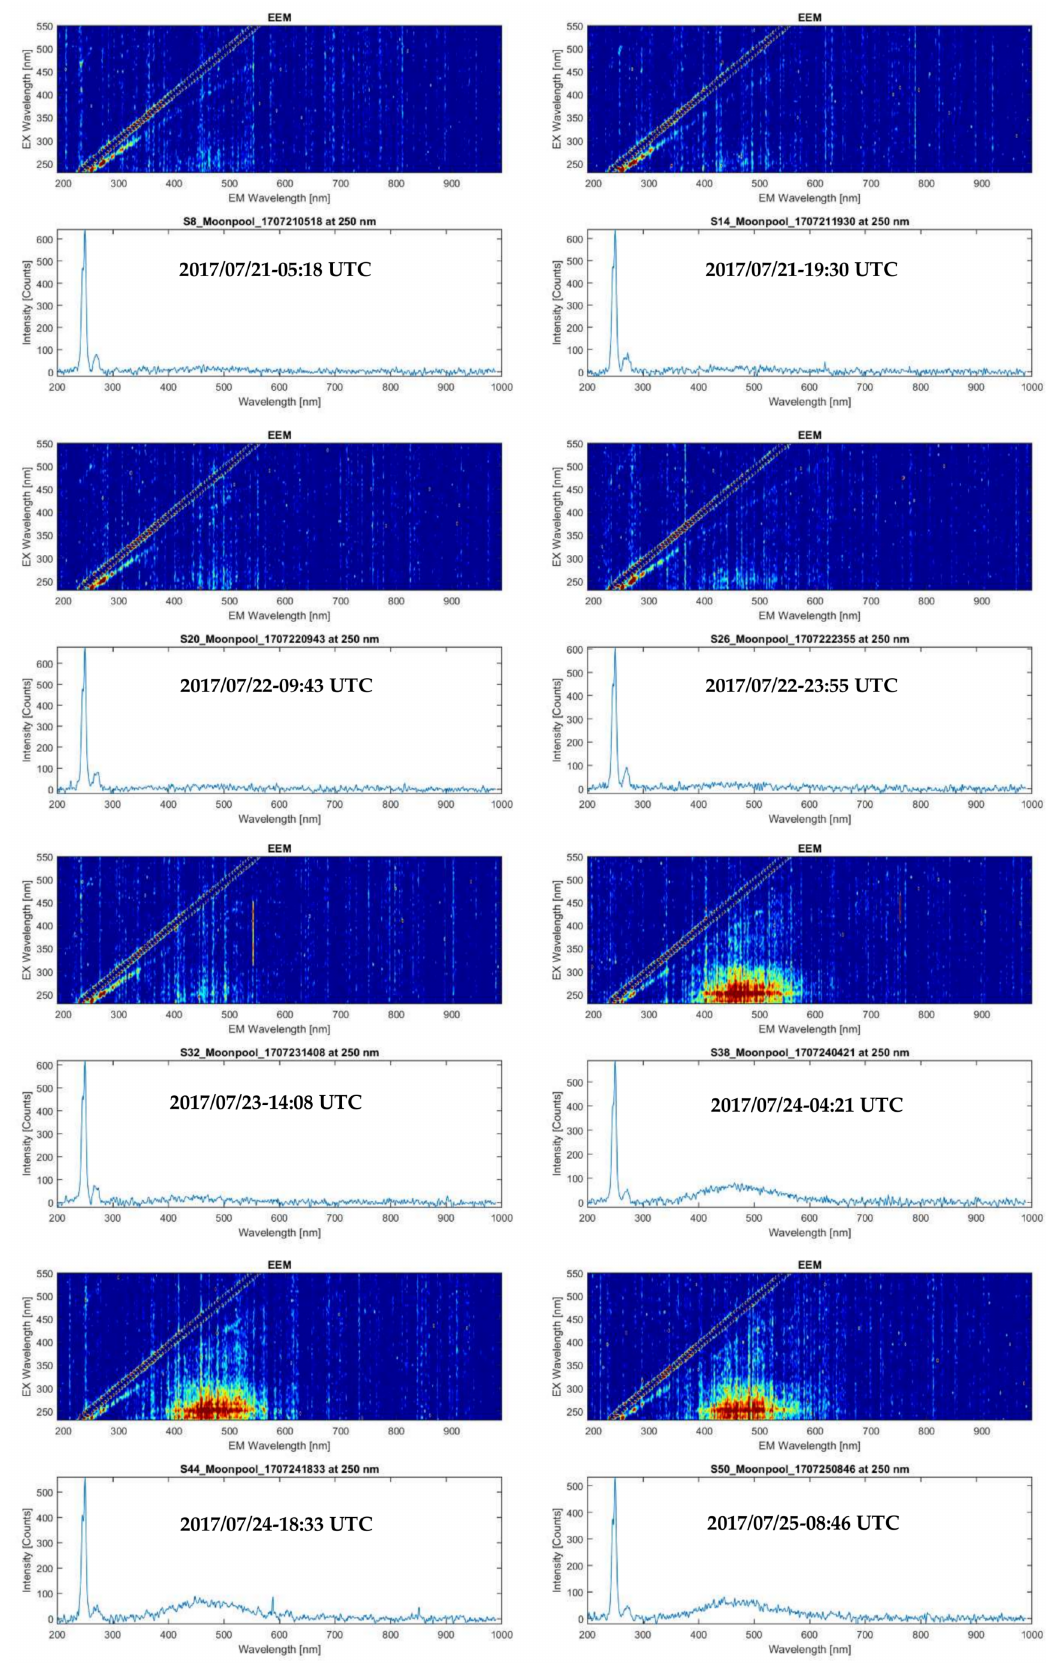
Figure A3. In situ underway measurements of EEM spectra, obtained from the moonpool of R/V Heincke (HE491) along transect from the coastal ocean into the